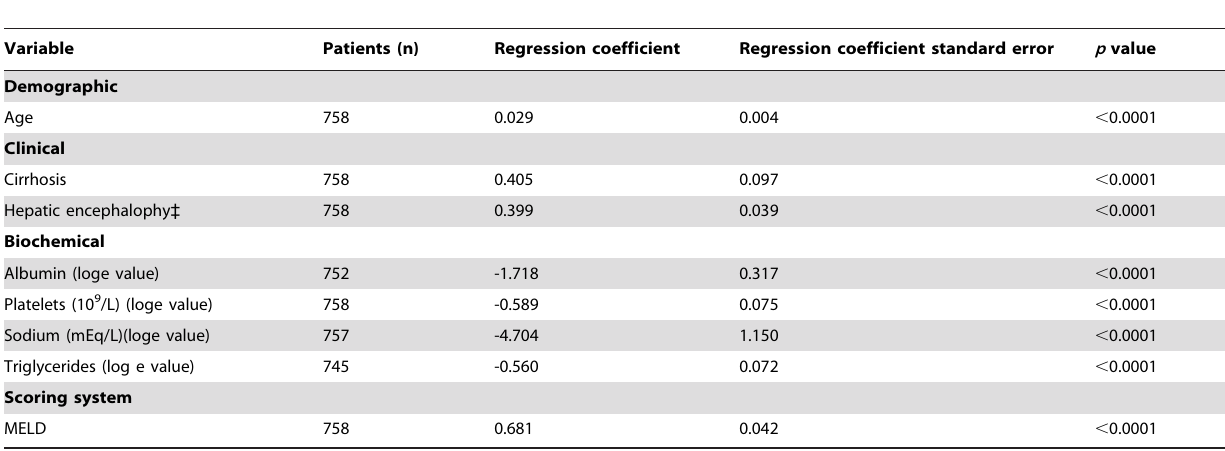
Table 3. Bivariate assessment of risk factors for death by any cause among the training cohort.